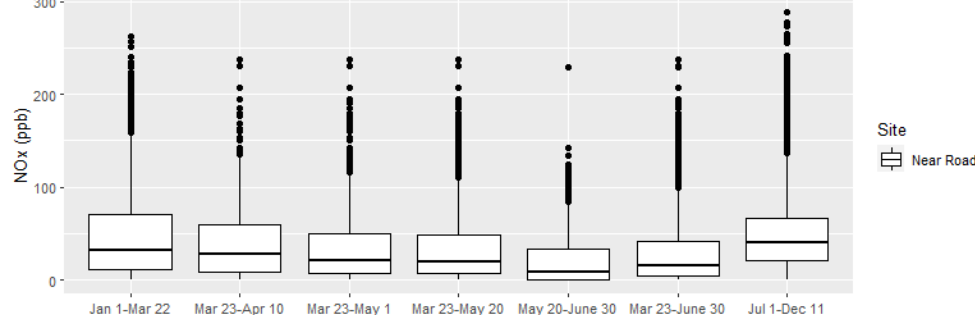
Figure 12. Boxplots of hourly NO X during each time period of interest during 2020 at the Near Road site.